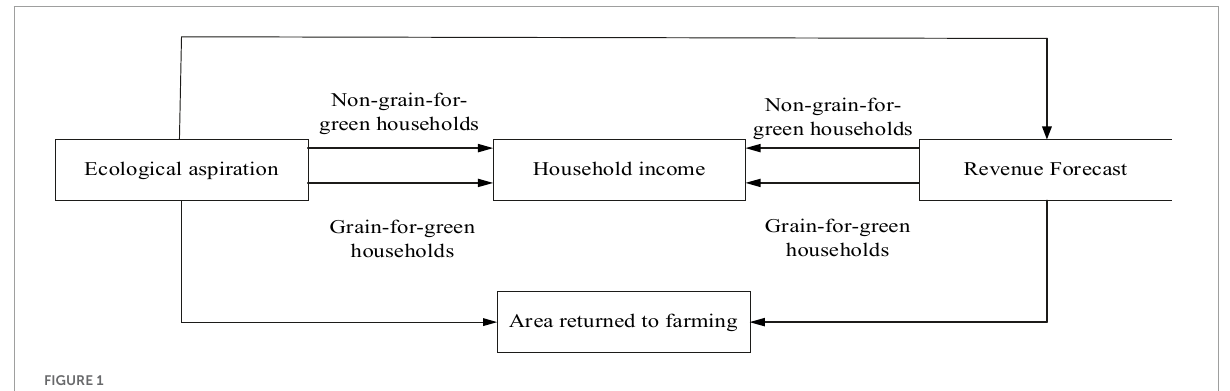
FIGURE1 Mechanism of ecological aspiration on decision-making and economic effect of G.G.P.